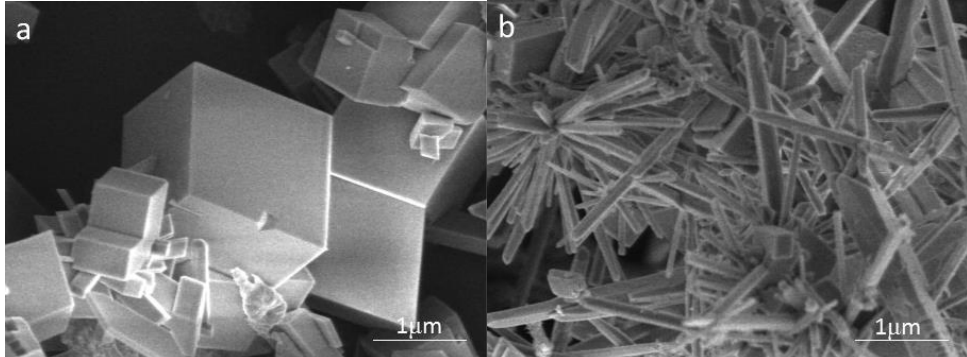
Figure 7. The scanning electron microscope ( SEM) images of the calcium carbonate crystals formed in the blank ( a ) and the scale-forming solution containing 100 mg/L carbon nanoparticles ( b ).